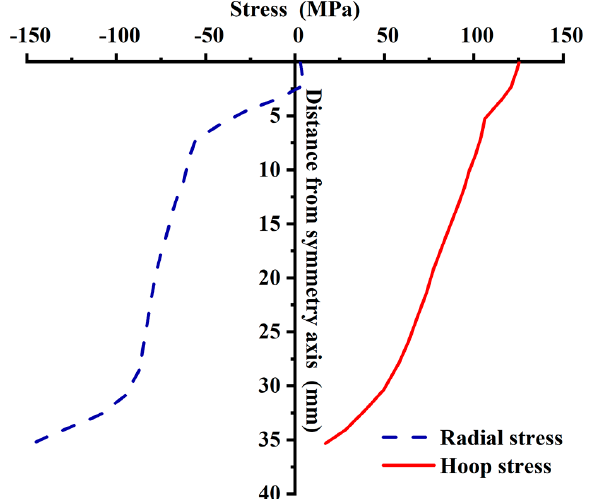
Figure 16. The stress distribution of the inner wall of the tray by numerical simulation.